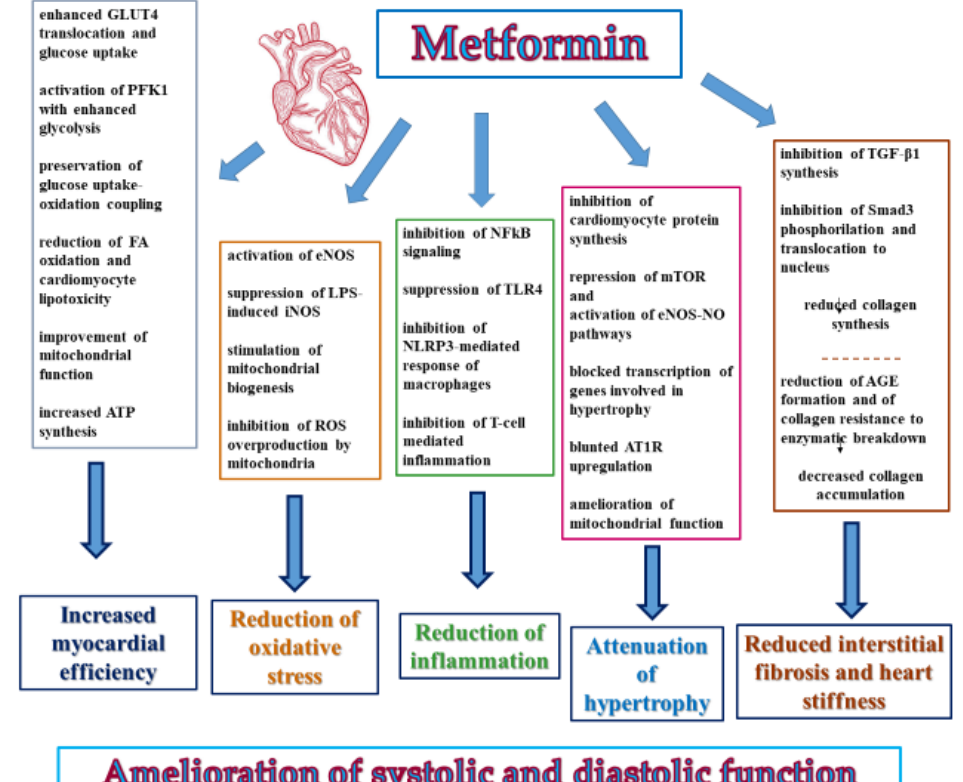
Figure 3. Main mechanisms of cardio-protection by metformin in failing heart (data from preclinical studies). AGE: advanced glycation endproducts; AT1R: AngII type 1 receptor; eNOS: endothelial ni- tric oxide synthase; FA: fatty acid; GLUT4: glucose transporter protein type-4; iNOS: inducible nitric oxide synthase; LPS: lipopolysaccharide; mTOR: mechanistic target of rapamycin; NF-kB: nuclear factor-kB; NO: nitric oxide; PFK1 phosphofructokinase 1; ROS: reactive oxygen species; TGF- β 1: trans- forming growth factor β 1; TLR4: Toll-like receptor